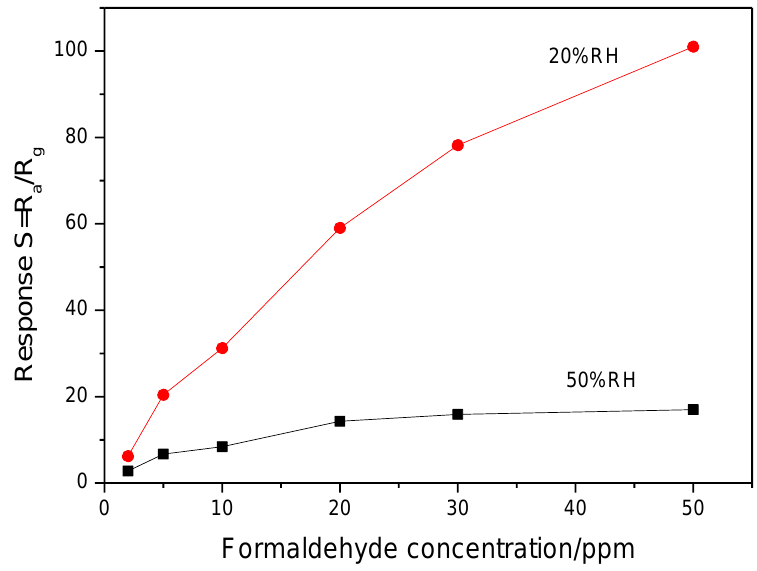
Figure 10. Responses of MFI-S coated sensor to 2–50 ppm formaldehyde in 20% RH and 50% RH.